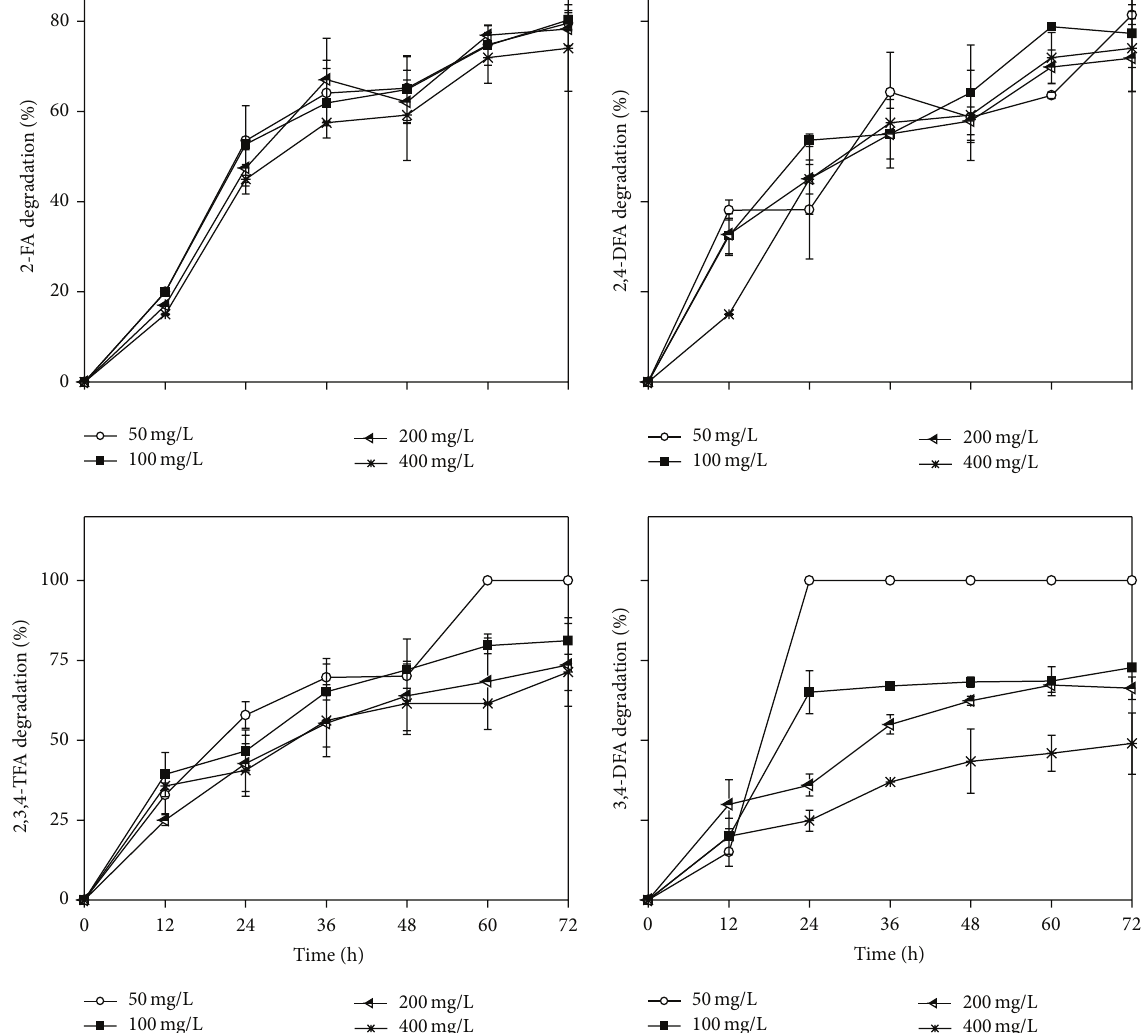
Figure 5: Second-class substrate fluoroaniline degradation in cometabolism